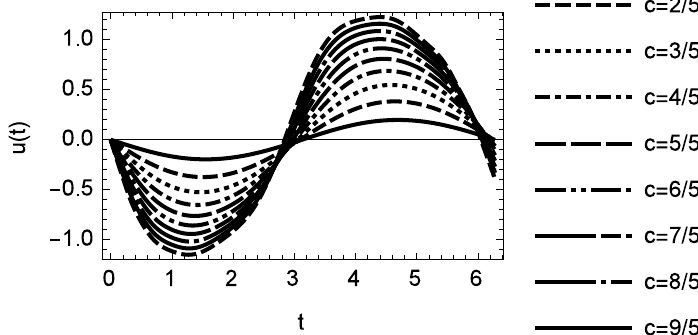
Figure 16. Solution of Levinson’s non-linear Volterra integral equation for variations of c in the range of f c g 2 ; 1 = 5 . c =1 = 5